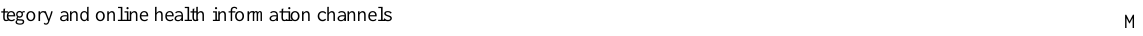
Table 1. Descriptive statistics of online channel use in Beijing, China (N=542).